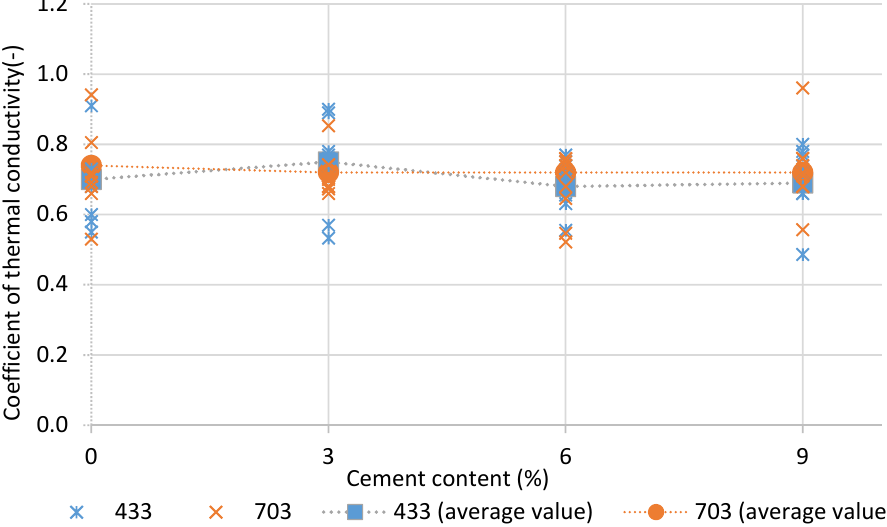
Figure 10. Results of CSRE coefficient of thermal conductivity.